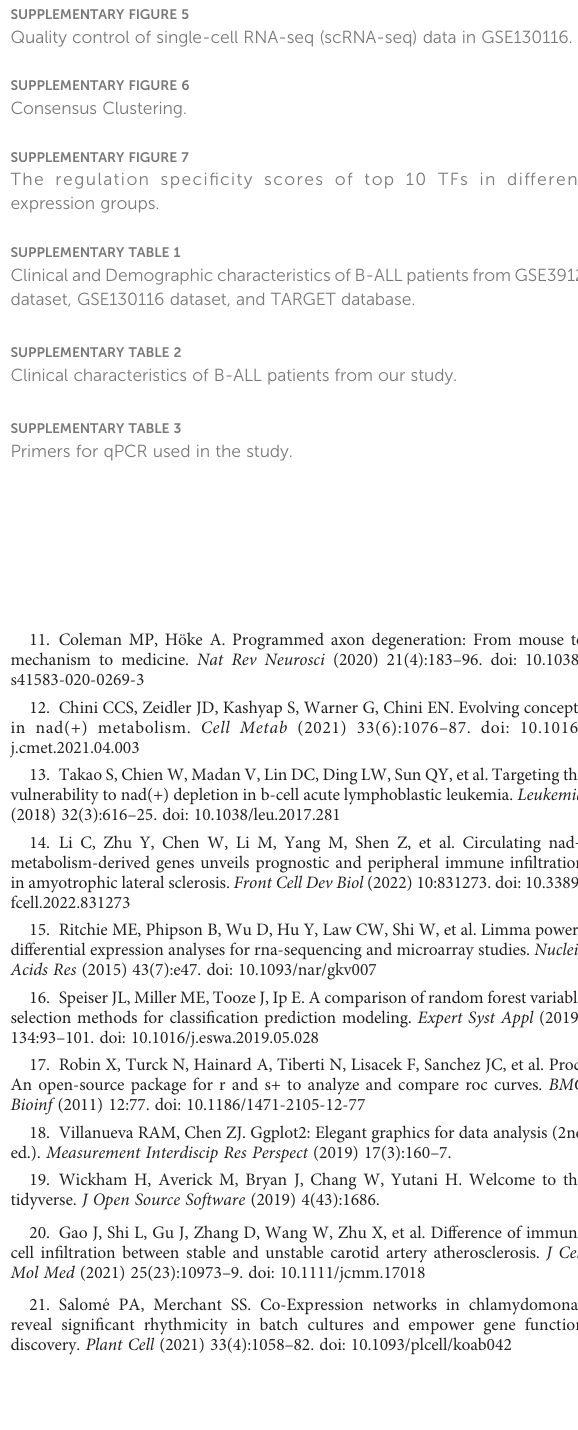
SUPPLEMENTARY FIGURE 1 The work fl ow chart of this study. SUPPLEMENTARY FIGURE 2 Enrichment analysis. SUPPLEMENTARY FIGURE 3 The cross-validation method to screen out 3 biomarkers and ROC curve. SUPPLEMENTARY FIGURE 4 The proportions of 22 types of immune cells in GSE3912. SUPPLEMENTARY FIGURE 5 Quality control of single-cell RNA-seq (scRNA-seq) data in GSE130116. SUPPLEMENTARY FIGURE 6 Consensus Clustering. SUPPLEMENTARY FIGURE 7 The regulation speci fi city scores of top 10 TFs in different expression groups. SUPPLEMENTARY TABLE 1 Clinical andDemographic characteristics of B-ALL patients from GSE3912 dataset, GSE130116 dataset, and TARGET database.